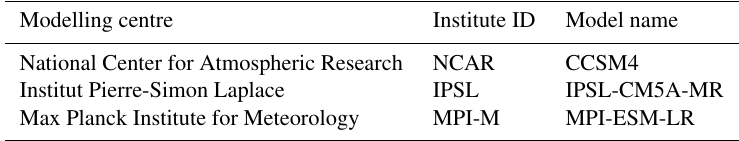
Table 1. CMIP5 models and modelling groups used to provide climate forcing data for LPJ-GUESS in this study. Modelling